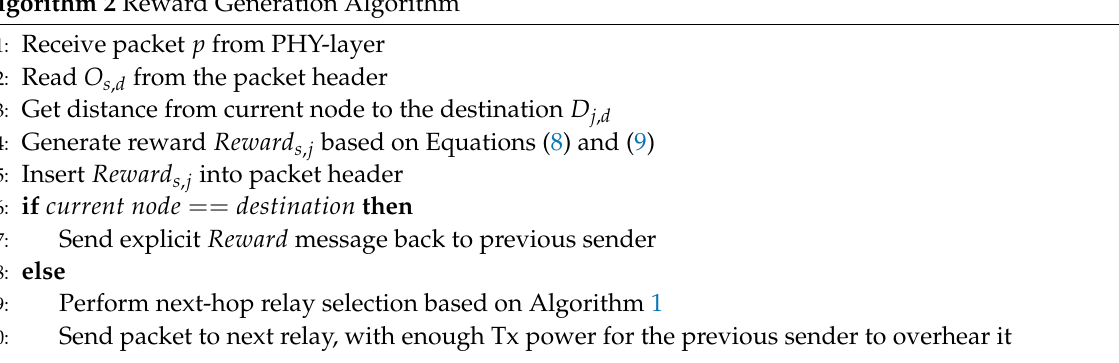
Algorithm 2 Reward Generation Algorithm